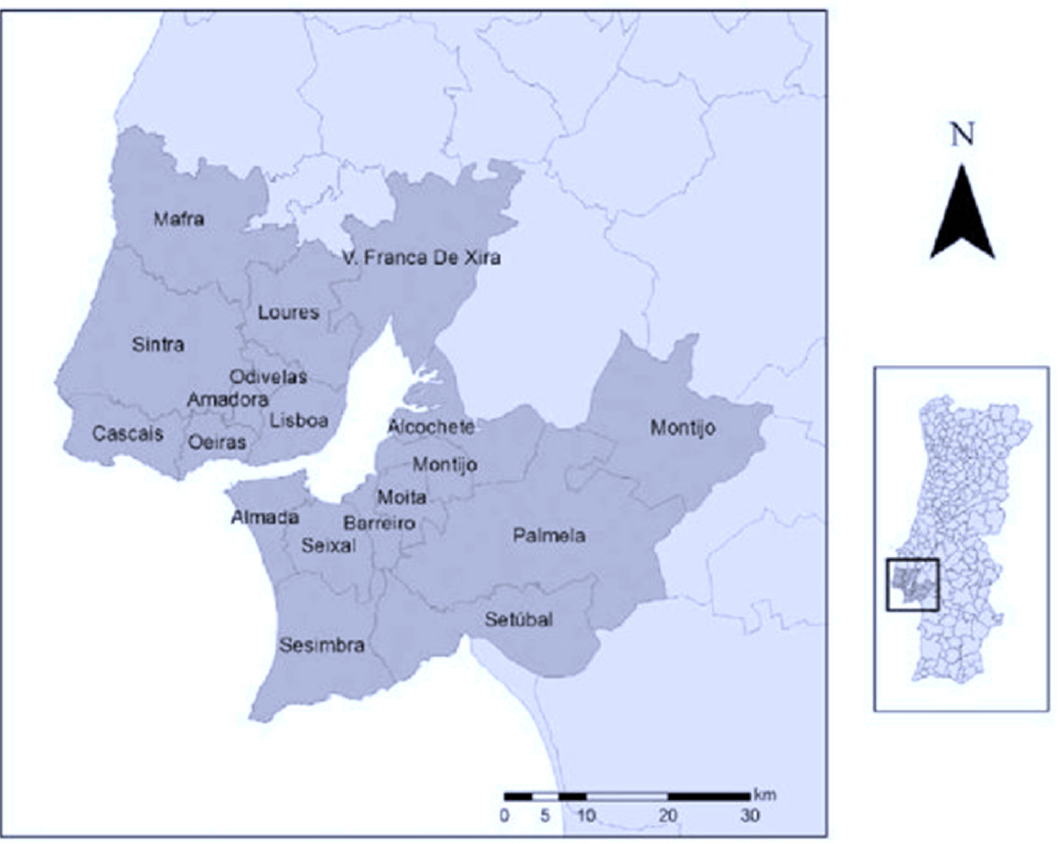
Figure 1. Illustrates the municipalities of the Lisbon metropolitan area. This figure was sourced from Gonçalves and Marreiros [45].